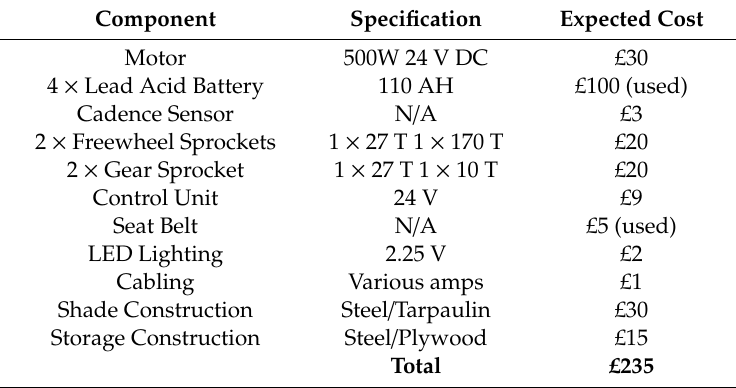
Table 5. Design specification and costing.